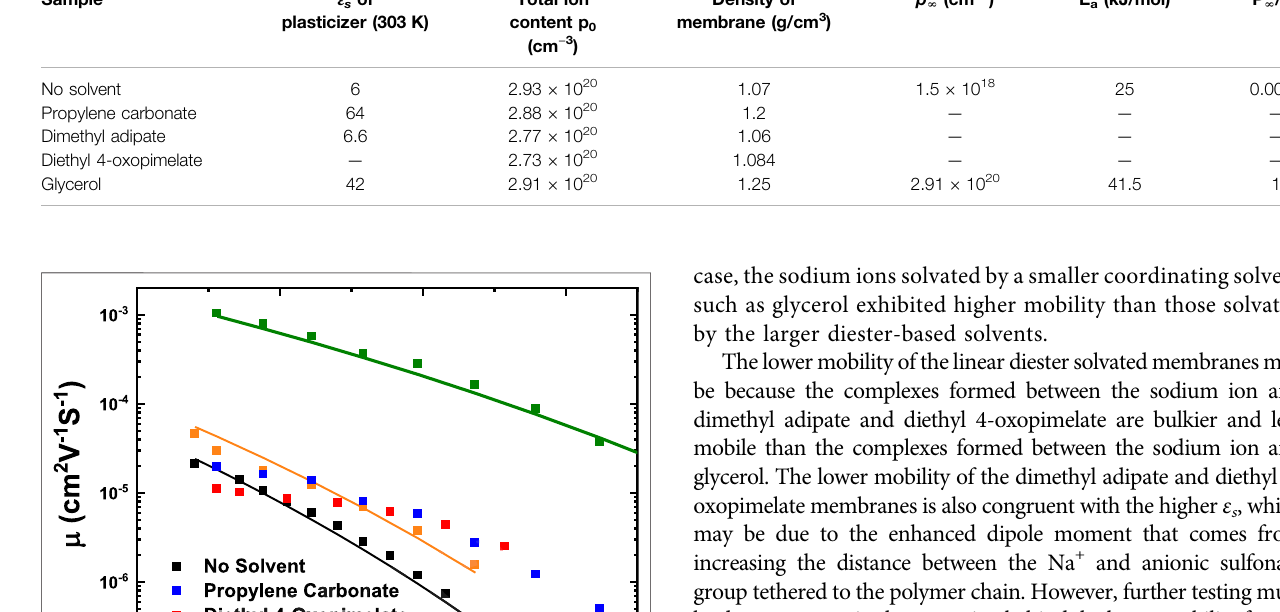
TABLE 3 | Dielectric properties of solvents and solvated gel polymer electrolyte membranes determined from electrode polarization analysis. Sample